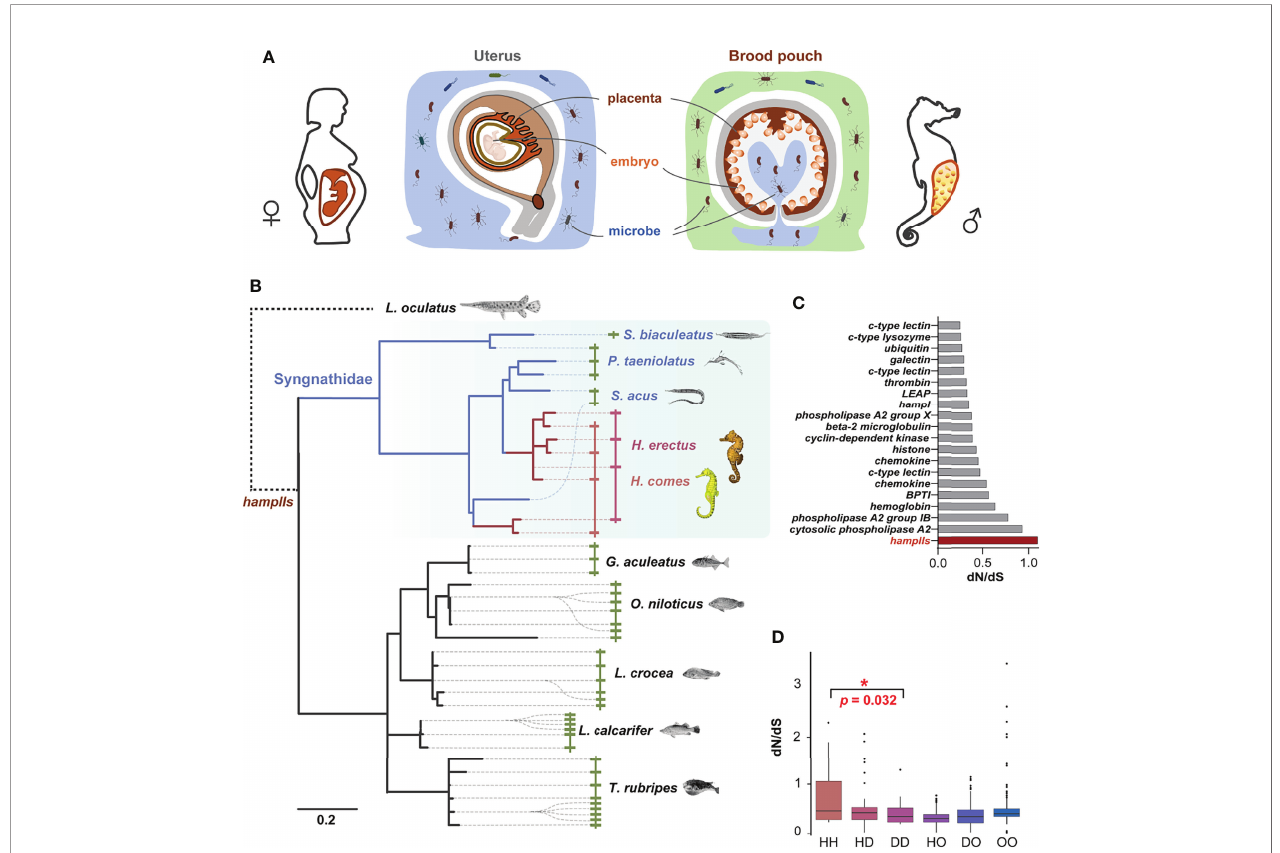
FIGURE 1 | HampII gene co-option in male pregnancy in seahorse. (A) Seahorses have a sophisticated brood pouch with a placenta structure inside, which is functionally similar to the uterus and placenta in mammals, and plays an important role in preventing uncontrolled bacterial growth in the closed nutrient-rich environment, without damaging the developing embryos during pregnancy. (B) Phylogenetic analysis (Bayesian tree) showed taxonomic- or lineage- speci fi c expansions in hampII genes (left), and synteny analysis demonstrated that hampII genes contained tandem duplicated sequences in the same scaffold (right). HampIIs in Syngnathidae were highlighted in blue background, seahorse hampIIs in red line, and other Syngnathidae hampIIs in blue line. (C) The dN/dS value of the seahorse branch of the hampII genes was the highest amongst all the antimicrobial peptides. Seahorse hampIIs were denoted in red. (D) The pairwise dN/dS values between hampII gene pairs was signi fi cantly higher in seahorses than other Syngnathidae (H, seahorses; D, Syngnathidae but not seahorse; O, other teleost species) (*, p <